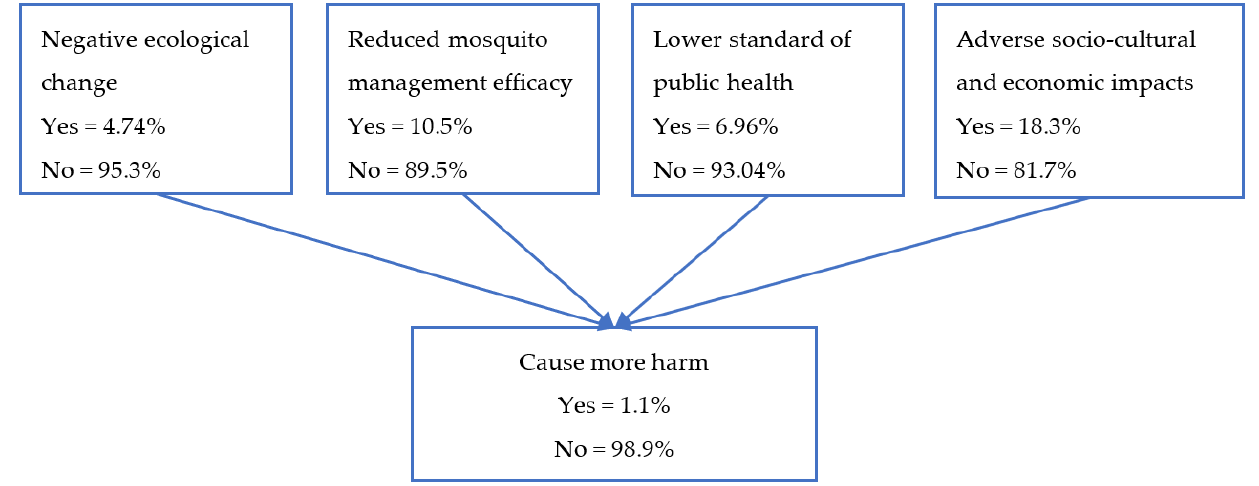
Figure 7. Estimated likelihood of the adverse impacts of the release of Wolbachia associated with four identified hazards.